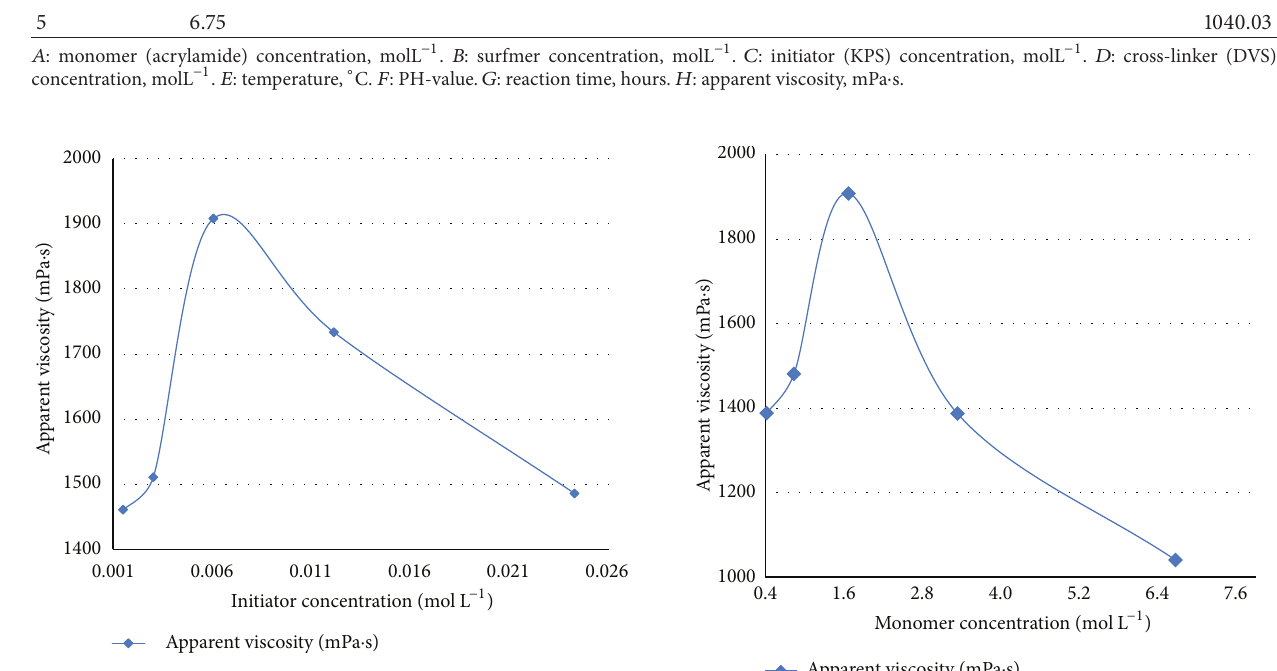
Figure 6: Effect of initiator concentration on apparent viscosity.